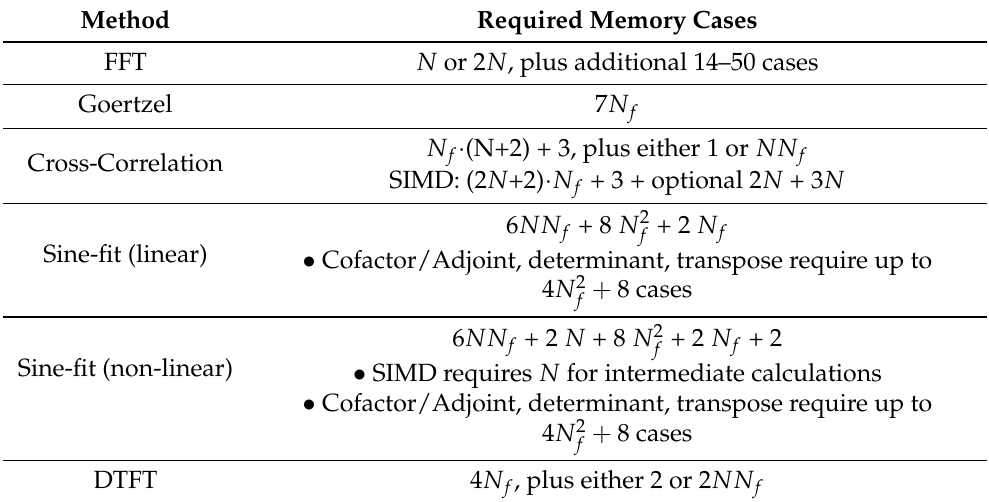
Table 3. Comparison between the Memory Allocation Excluding Signal Length Required for the AC signal